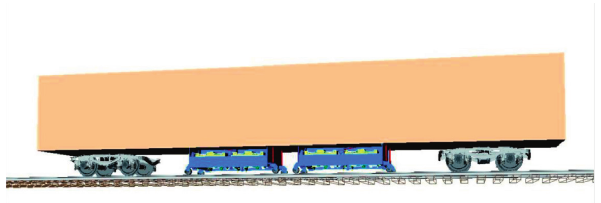
Figure 10: Multibody model of rail-grinding train.